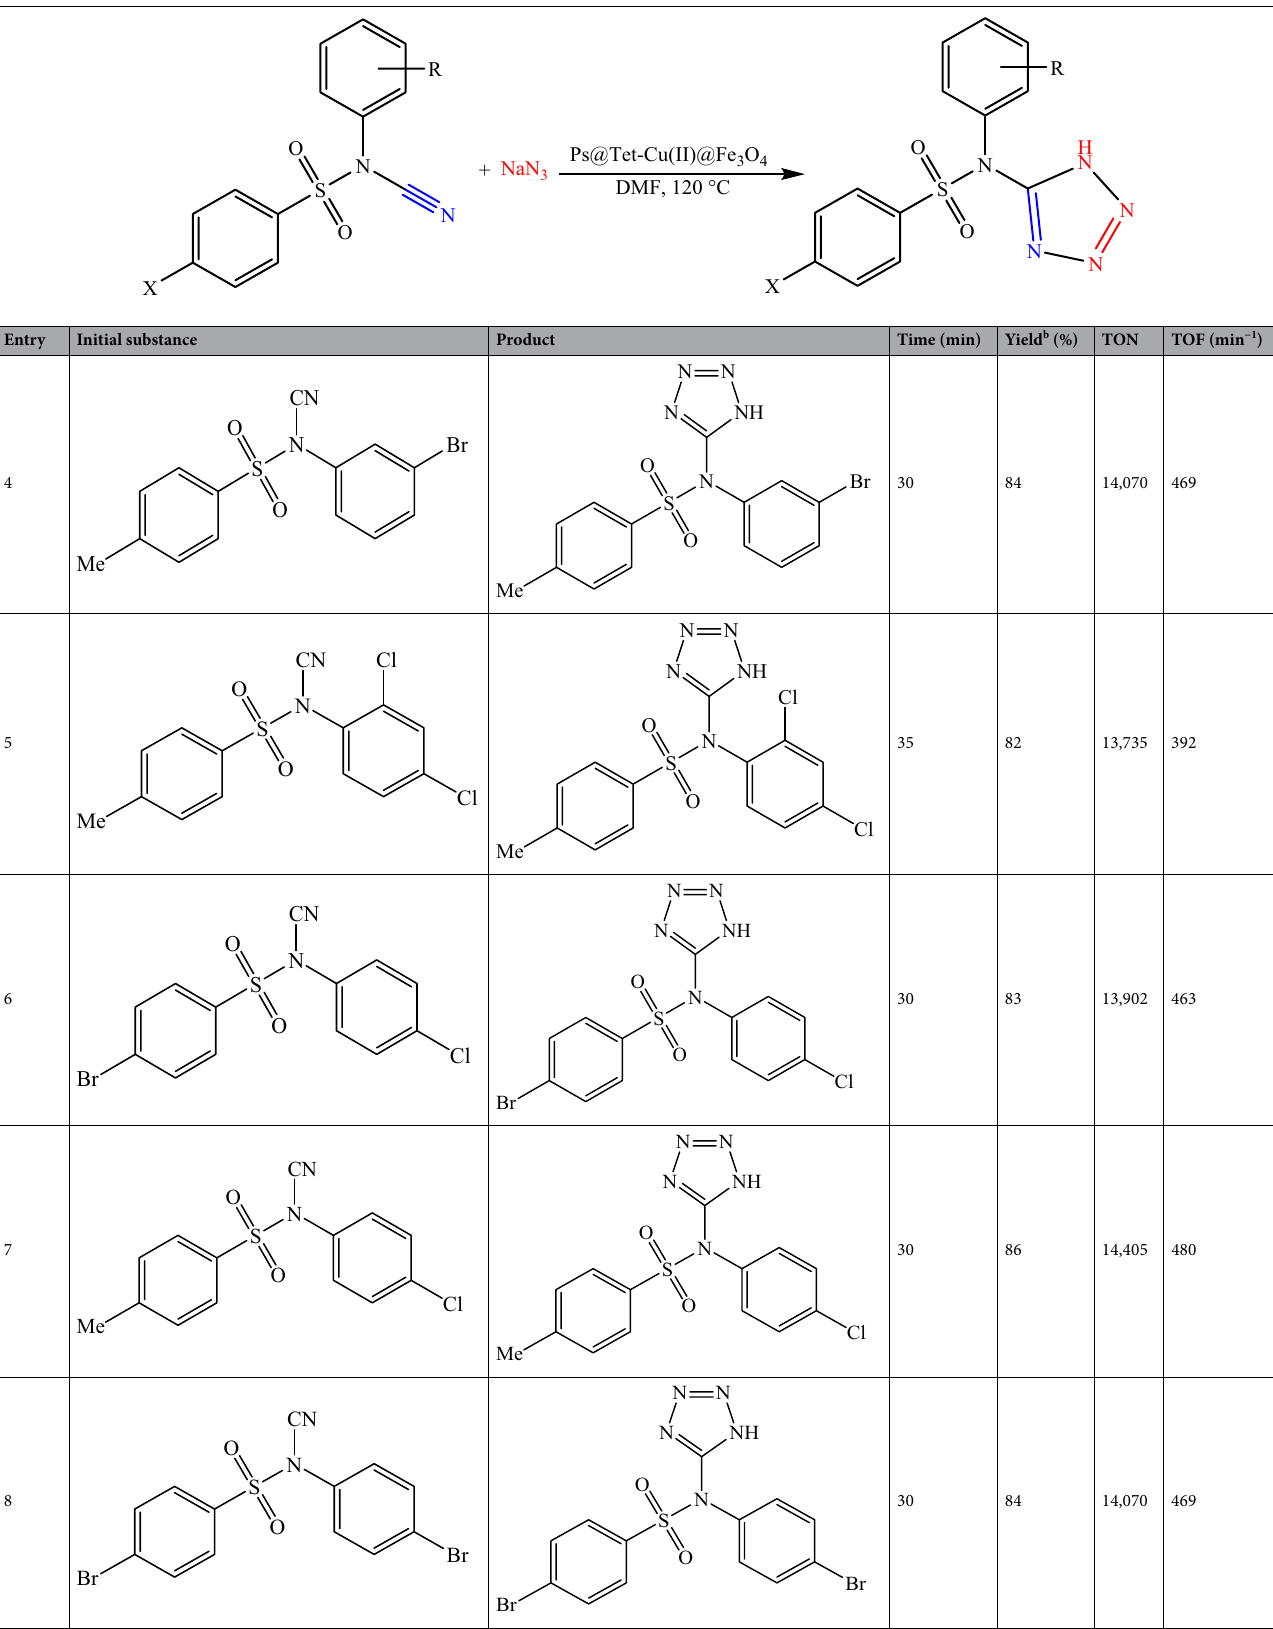
Table 2. Synthesis of tetrazoles using Ps@Tet-Cu(II)@Fe 3 O 4 complex. a a Reaction conditions: N -sulfonyl- N